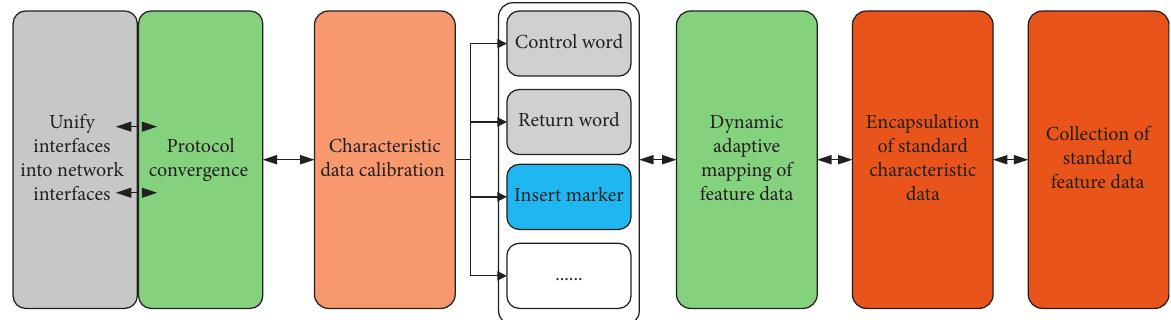
Figure 11: SDN-protocol interface aggregation and